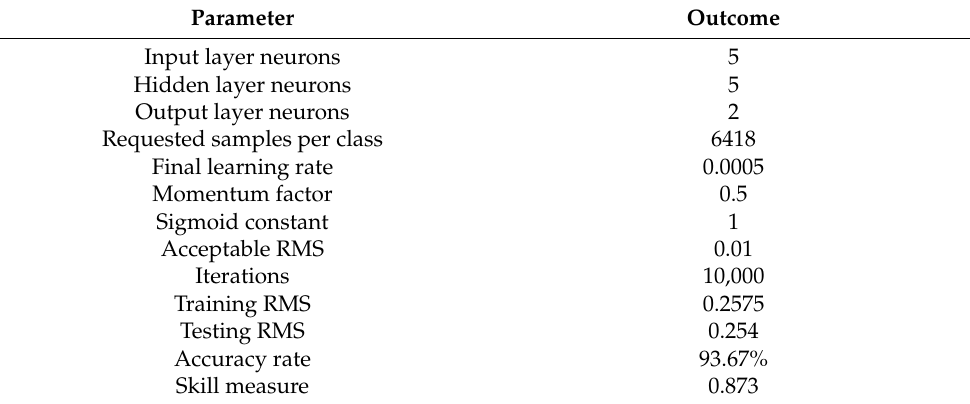
Table 2. Parameters and performance of the MLP model.